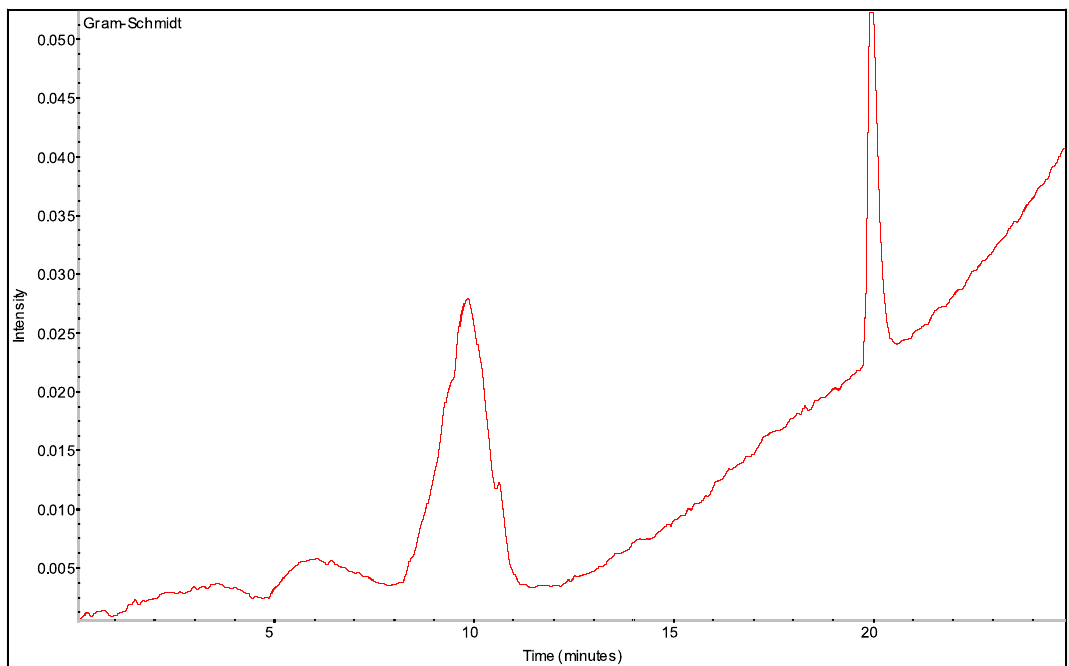
Figure 7. Gram-Schmidt of gas products from thermal decomposition of